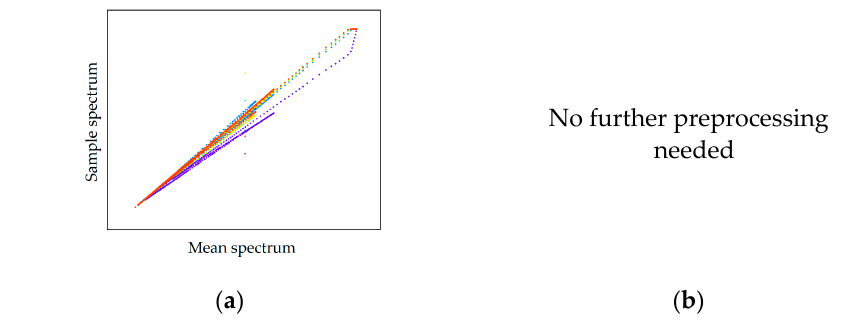
Figure 16 . Fluorescence spectral data for dissolution. ( a ) raw data, ( b ) preprocessed data. In this case no further preprocessing was necessary due to evaluation of scatter effects. Spectral data ( a ) and ( b ) have been previously published [6].